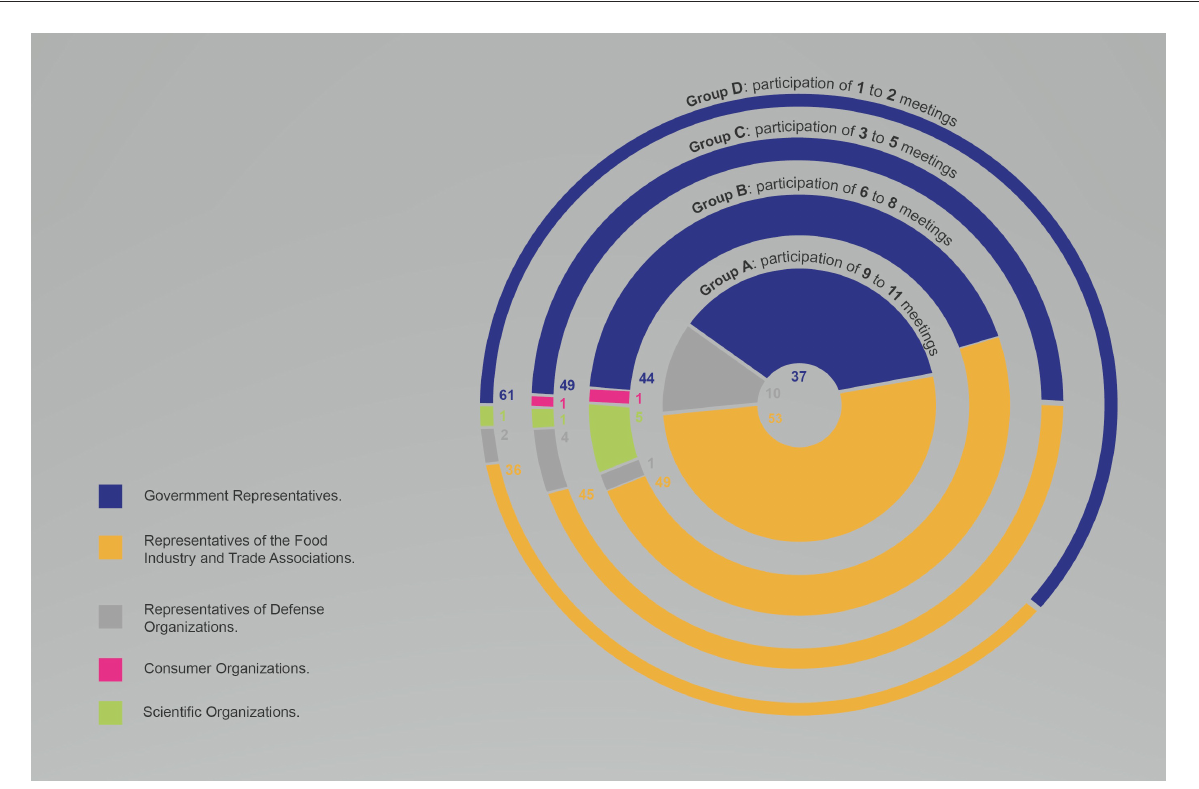
FIGURE2 The relative participation of actors according to interest group, attending CCNFSDU a , 2009–2019. a The Codex Committee on Nutrition and Foods for Special Dietary